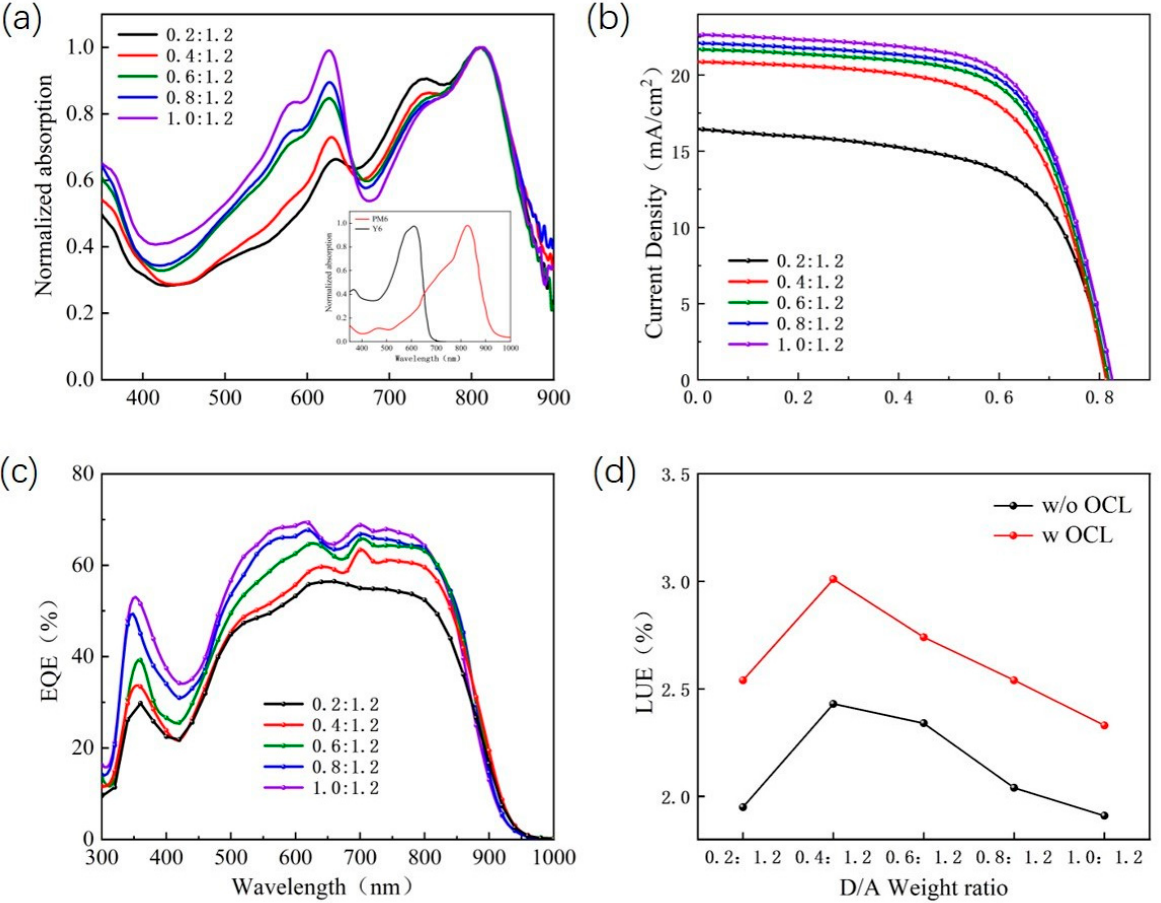
Figure 3. ( a ) The effect of mixed films with different D: A ratios on absorption spectra; Inset: Normalized absorption spectra of PM6 and Y6 films; ( b ) J–V characteristics, ( c ) EQE spectra measured for the ST-OSCs prepared using precursor solutions having different D: A ratios; ( d ) Variation of light utilization efficiency (LUE) in relation to the D: A weight ratio in ST-OSCs with and without